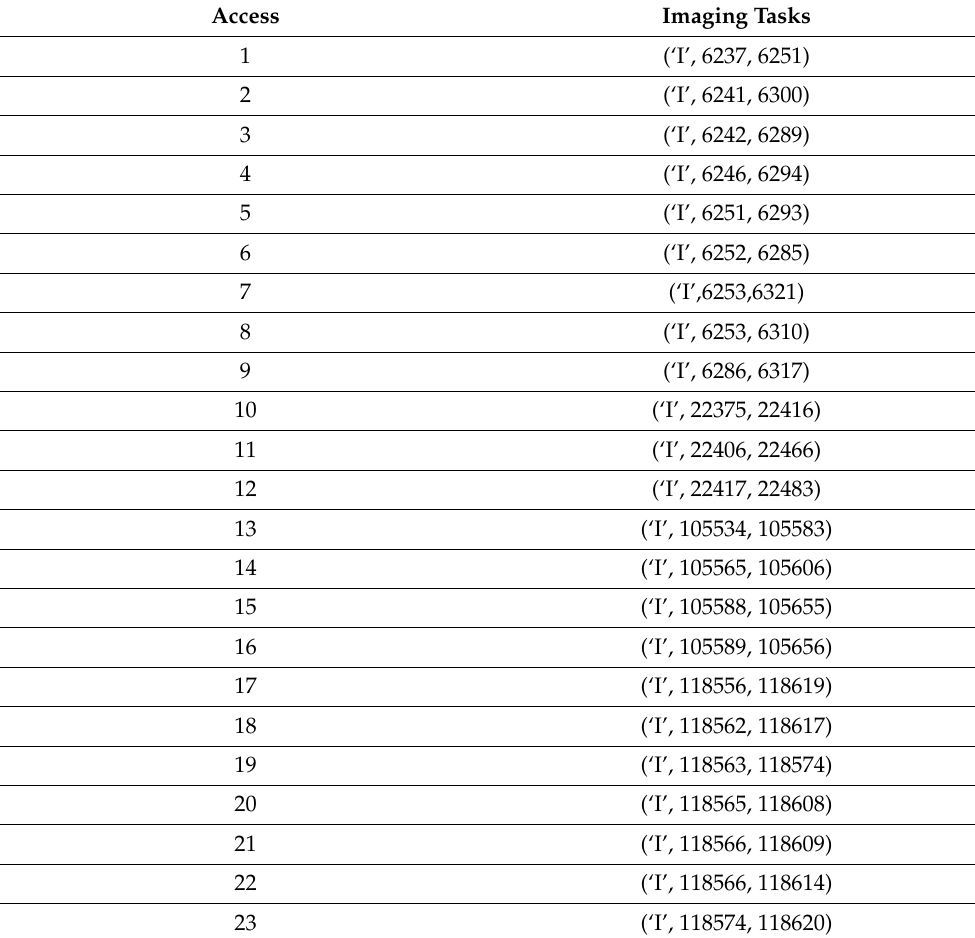
Table 3. List of Imaging